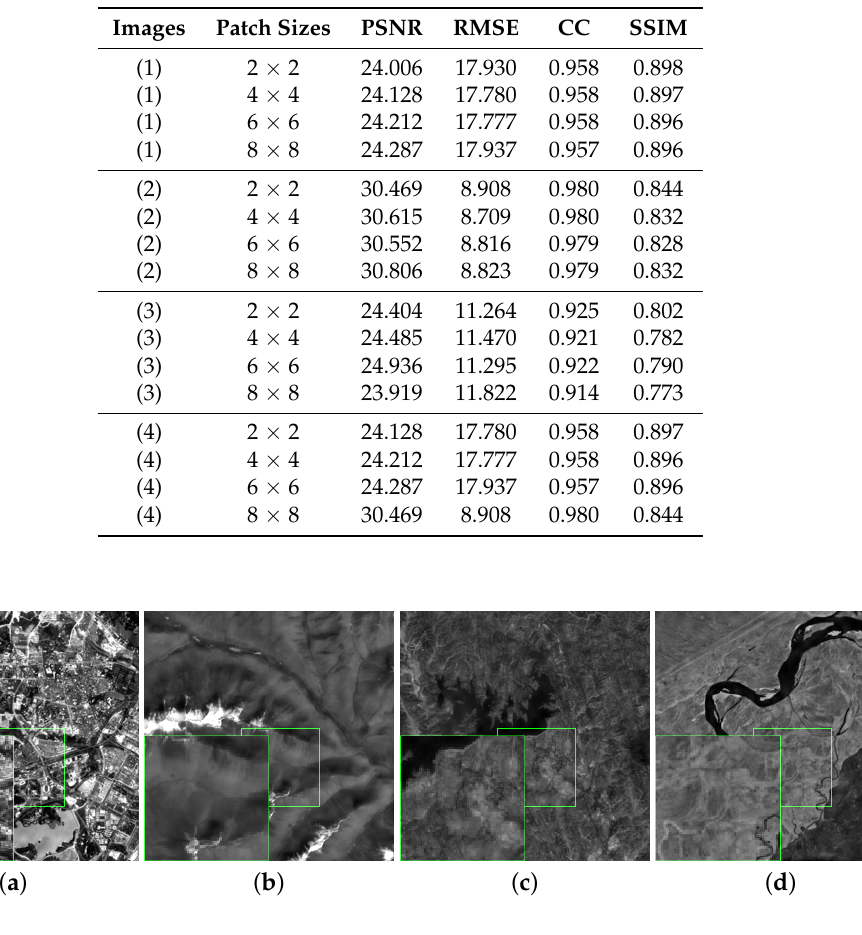
Figure 6. The reconstruction image of Landsat 7 and Landsat 8. ( a – d ) Reconstruction Image (1–4). ( a ) Reconstruction Image 1; ( b ) Reconstruction Image 2; ( c ) Reconstruction Image 3; ( d ) Reconstruction Image